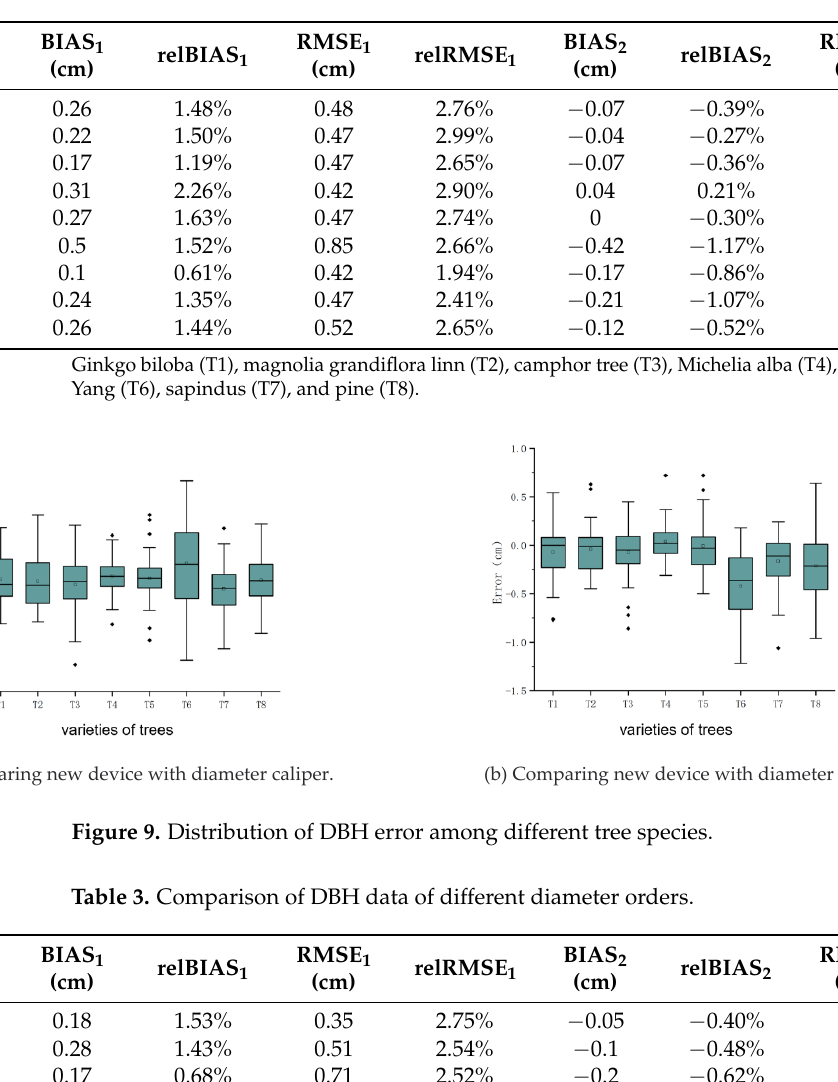
Table 2. Comparison of DBH data of different tree species.